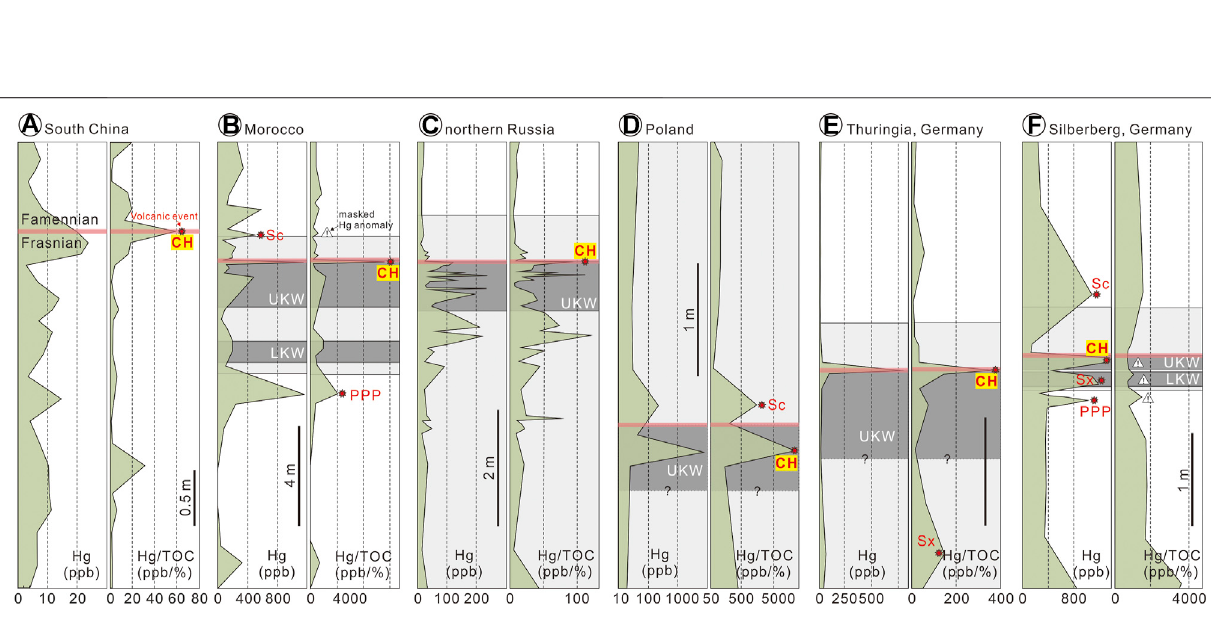
Frontiers in Earth Science |